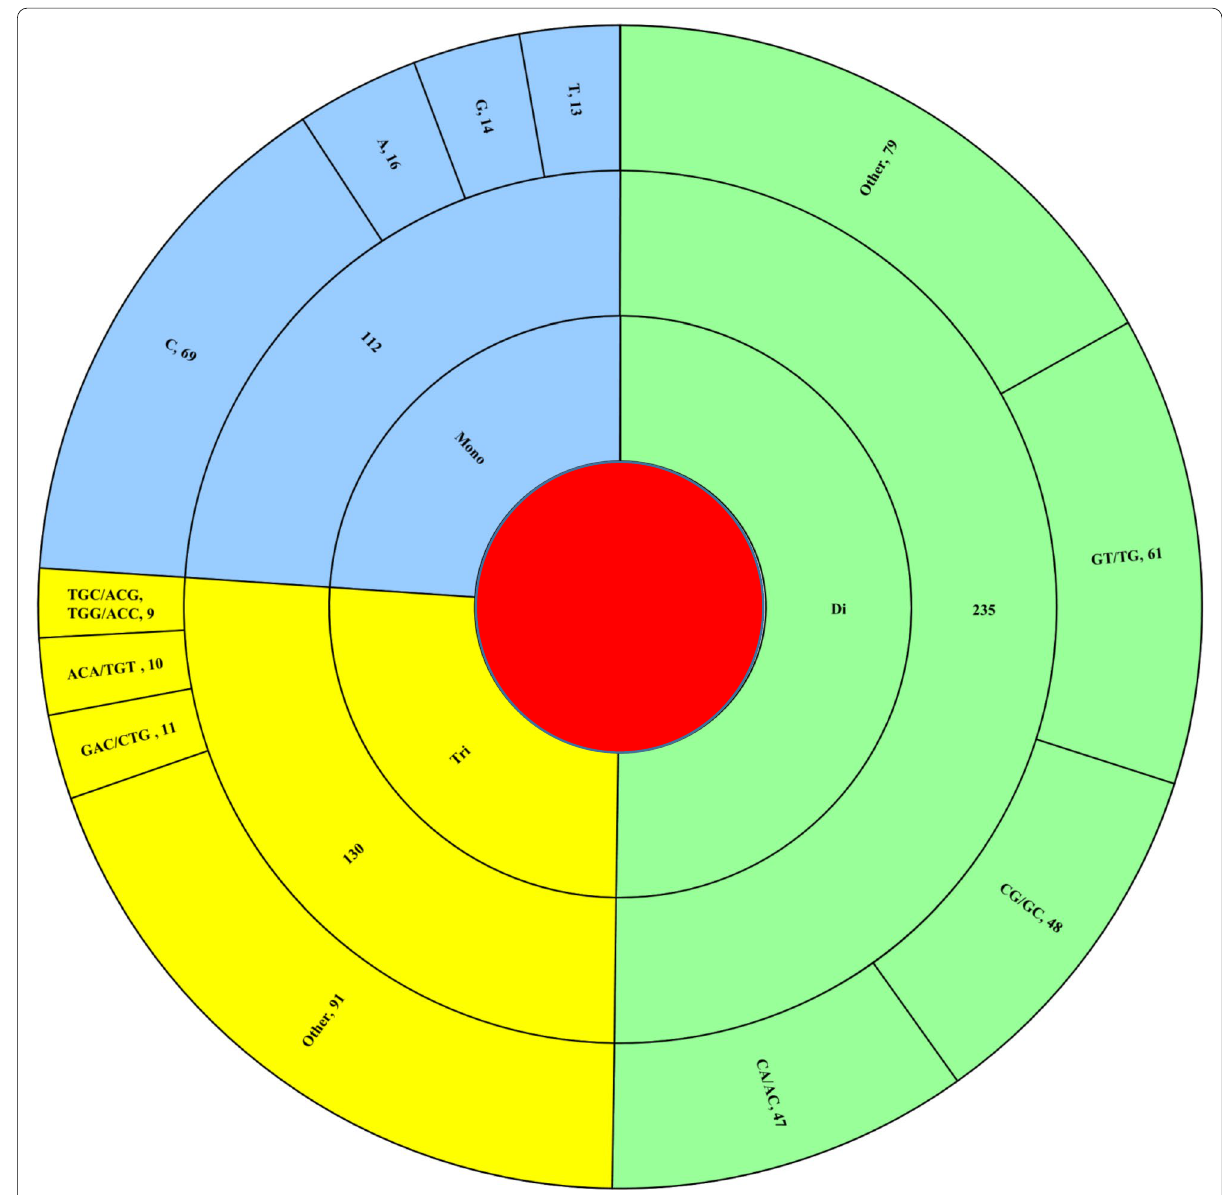
Fig. 3 Motif composition of mono-, di-, and tri-nucleotide Hepeviridae